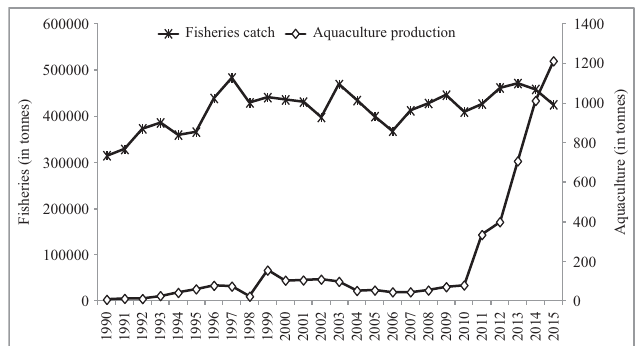
Fig. 5. Trends in aquaculture production in Senegal in comparison with the fi sheries total catch from 1990 to 2015.